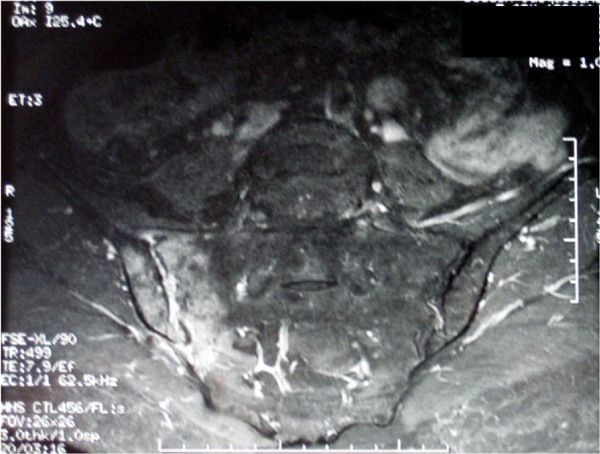
Magnetic imaging resonance scan showing persistent hypersignal of the right sacroiliac joint 3 months after diagnosis.